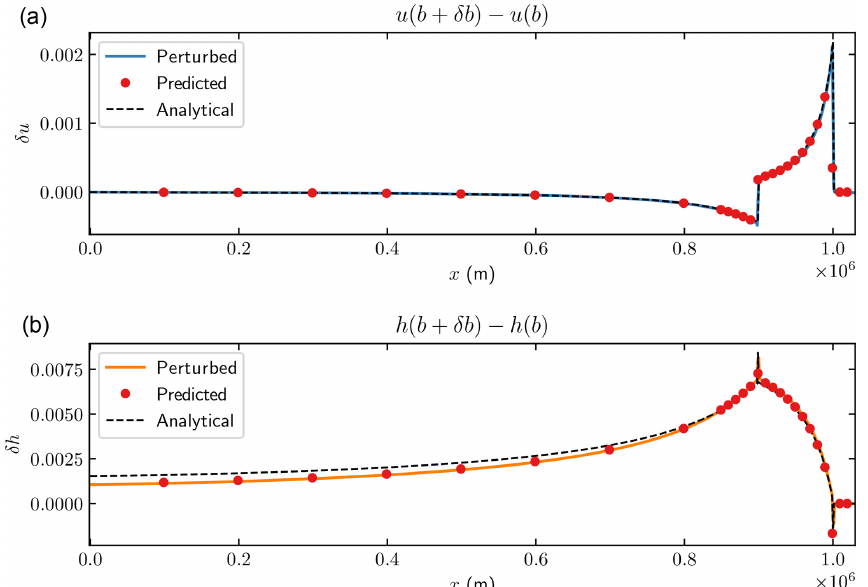
Figure 13. The changes in the horizontal velocity u (a) and surface elevation h (b) for SSA after 15000 years (close to the steady state) with 0 . 01m perturbation of b(x) in x ∈ [ 0 . 9 , 1 . 0 ]× 10 6 . Solid lines are the differences between the steady-state and perturbed solutions in Eq. (13). Red dots represent the estimated perturbation using Eq.